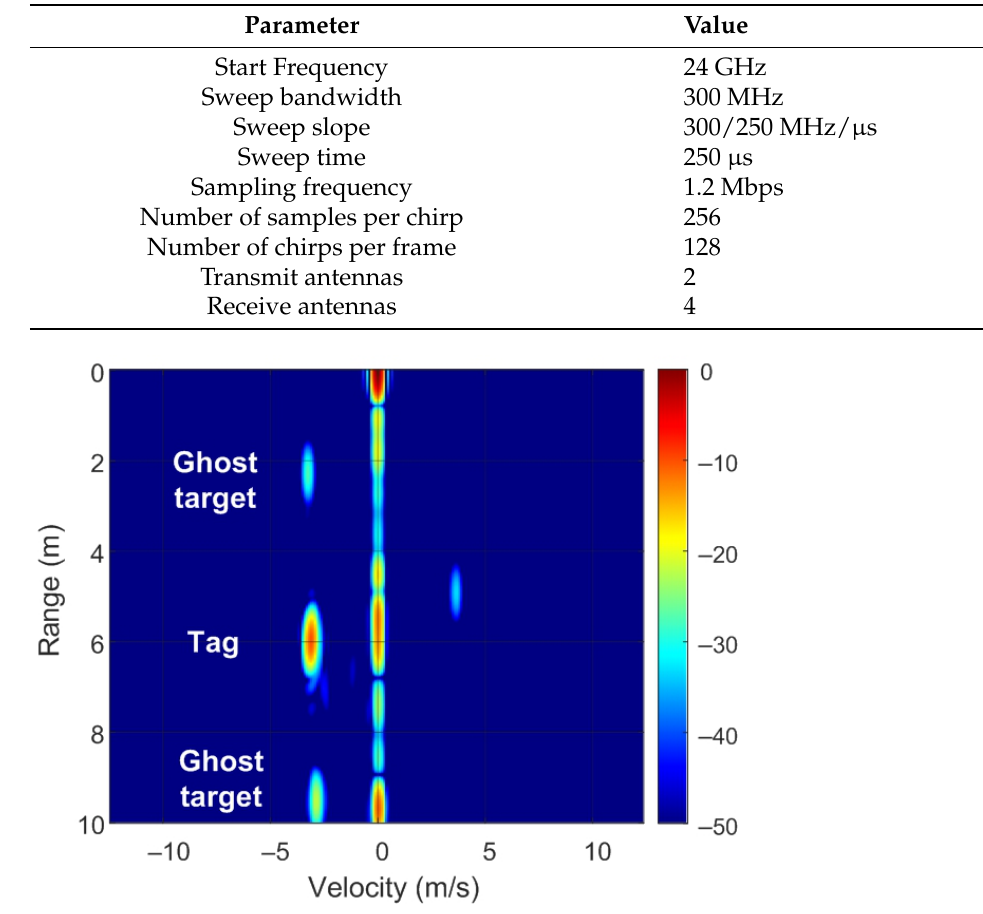
Figure 18. Measured range–Doppler map including two ghost targets at 3.5 m with the tag approach- ing the